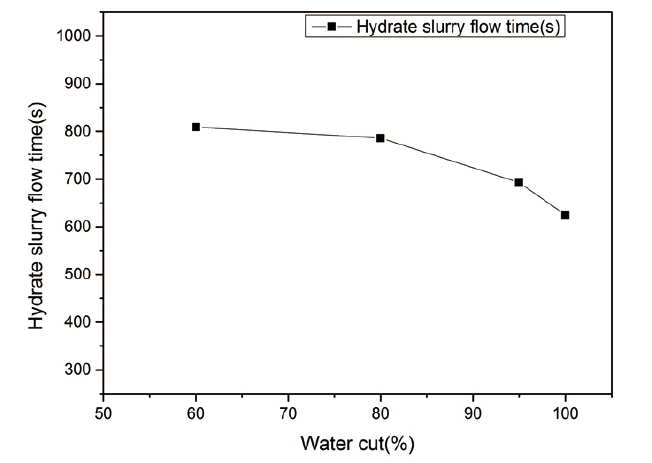
Figure 10. Curve of flow time of hydrate slurry under different water cut.